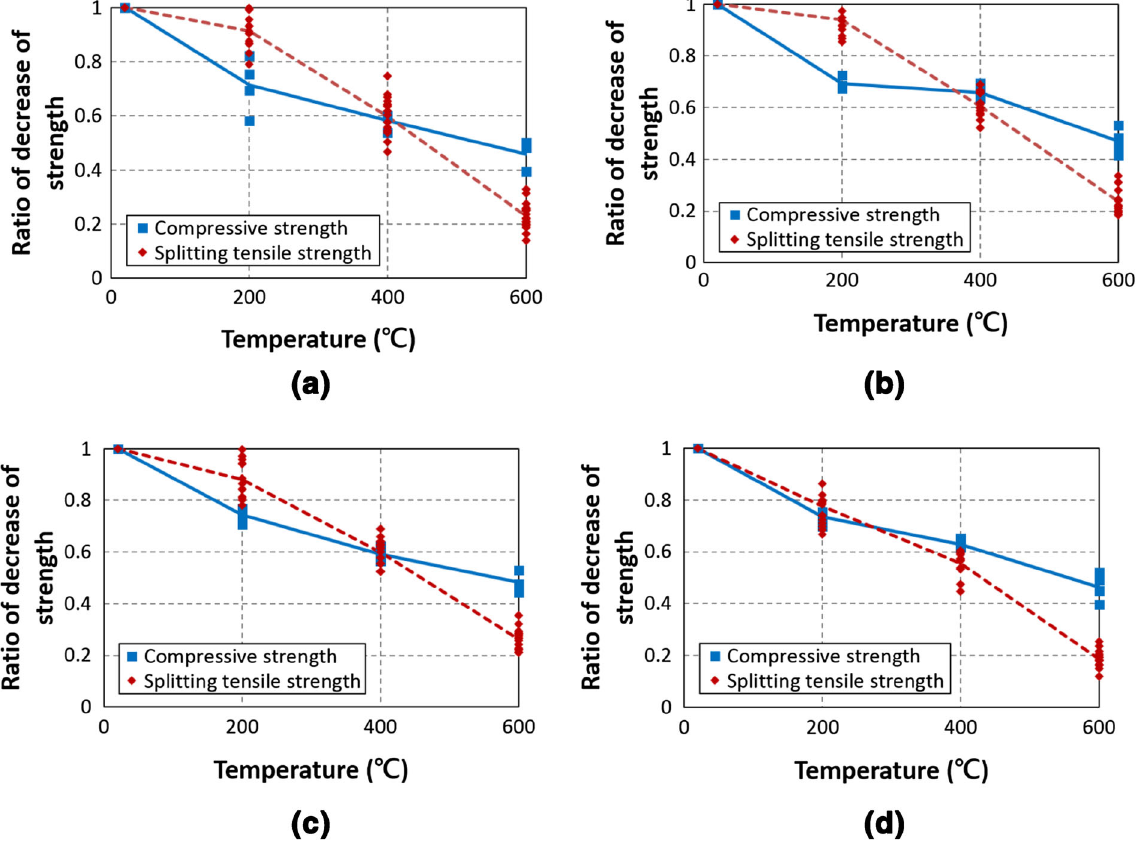
Fig. 7 Comparison of ratios of decrease of strength with temperature. a C1, b C2, c C3 and d